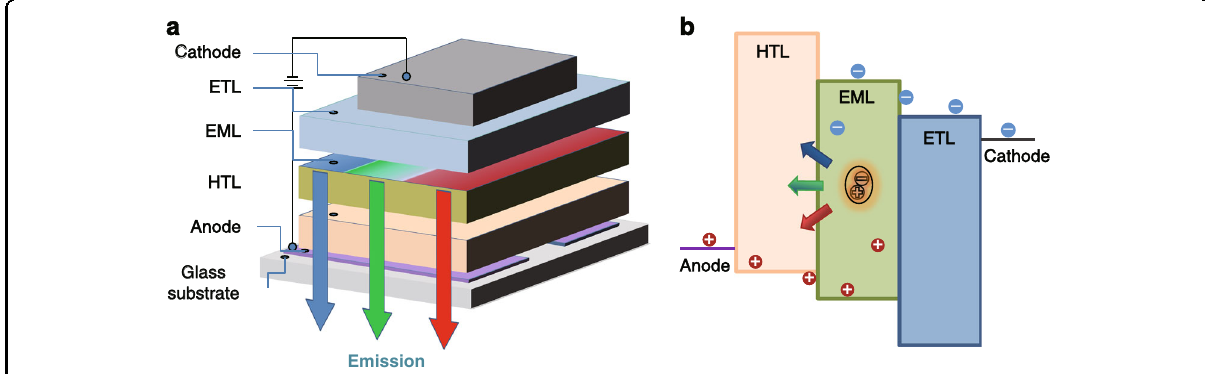
Fig. 3 Schematic depictions of OLEDs structure and EL principle. ( a ) Typical OLEDs structure; ( b ) EL principle of